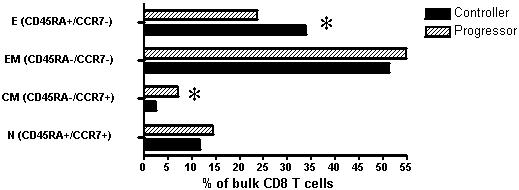
T cell differentiation profile in bulk CD8+ T cells.Based on the lineage markers, CD45RA and CCR7 bulk CD8+ T cells of HIV-1 Controllers (black bars) and HIV-1 progressors (hatched bars) were stratified into 4 subpopulations: effector (E), effector memory (EM), central memory (CM) and naïve (N) CD8+ T cells. Terminally differentiated (E) CD8+ T cells were of significantly higher frequency in HIV-1 Controllers (p = 0.017, Mann-Whitney), while Progressors had higher levels of CM cells (p = 0.02), indicated by asterisks (*).